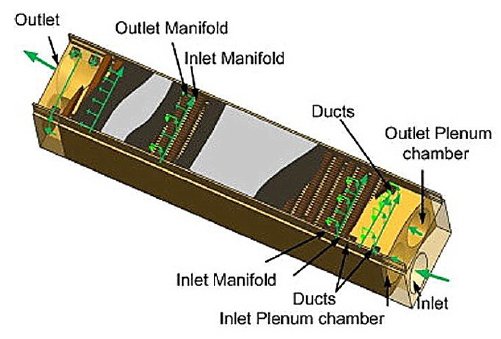
Figure 21. Schematic diagram of the multi-layer manifold microchannel testing unit [99].